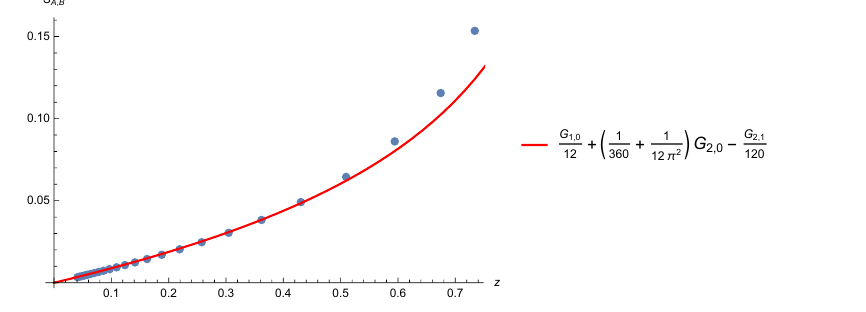
Figure 2 . Mutual information of two disks for 3 d free boson (0 < z < 0 : 75). R = 0 : 2. One can change the distance r to adjust the cross ratio z . The points are from the lattice computation. The light blue curve is the theoretical result up to the leading order z . The pink line is theoretical result up to the next-to-leading order z 2 . Note